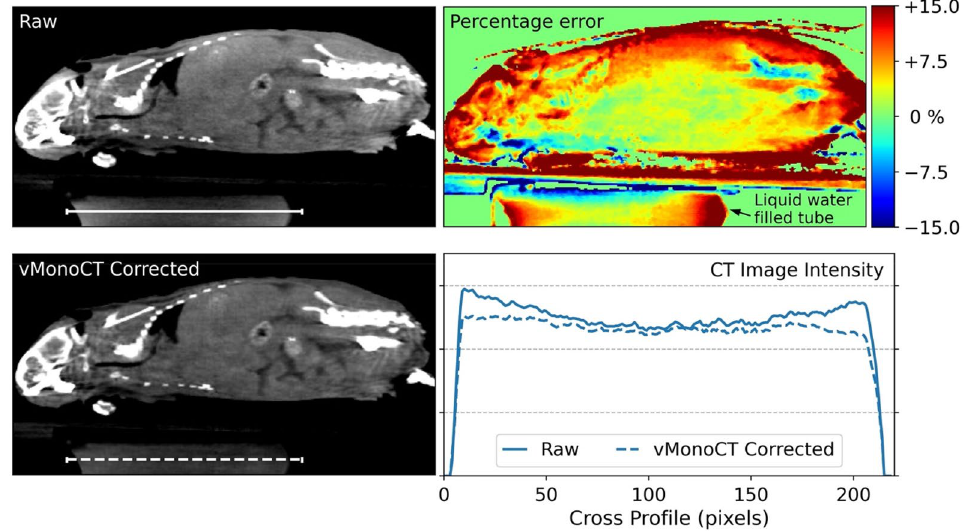
Figure 3. The raw and vMonoCT corrected SARRP µCBCT image reconstruction of a frozen mouse cadaver, including the imaging of a liquid water filled tube to evaluate cupping. The percentage error map is calculated between the raw image, and minus the vMonoCT corrected µCBCT image. An image cross profile was plotted through the liquid water filled tube for both